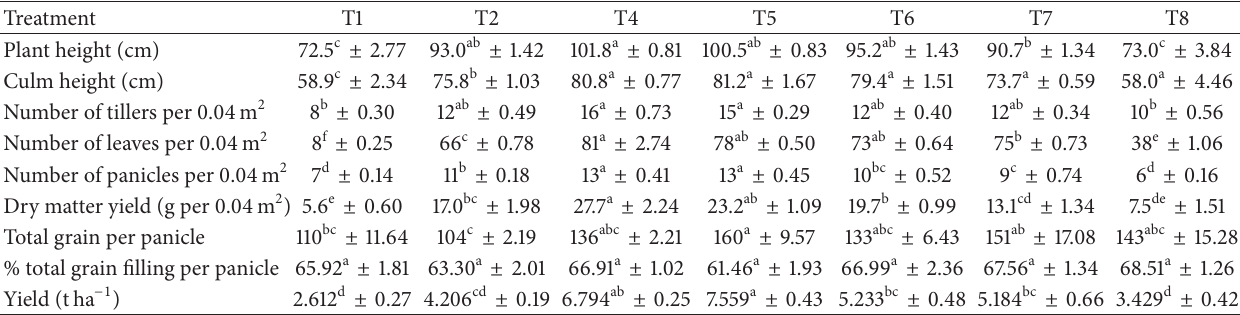
Table 8: Effects of biochar and nitrogen fertilization on measured variables of rice plants in the field study. Treatment